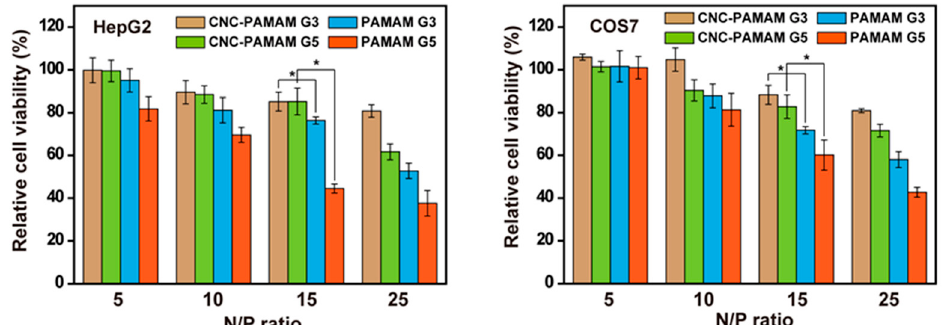
Figure 7. Cell viability of complexes in HepG2 and COS7 cells (mean ± SD, n = 6, * p < 0.05).